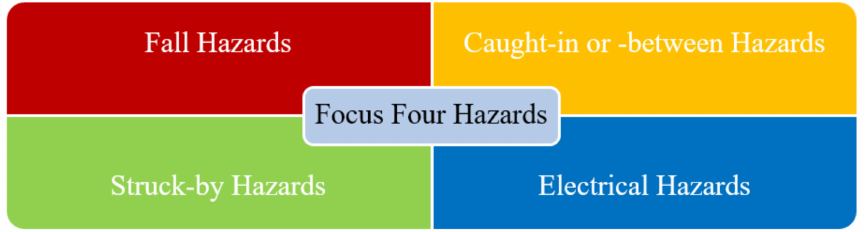
Figure 3. Schematic representation of the focus-four